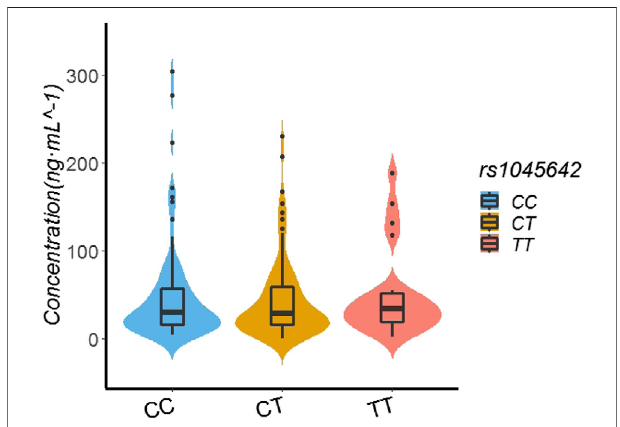
FIGURE 1 | Effect of SNP rs1045642 on Rivaroxaban dose of 155 recipients.